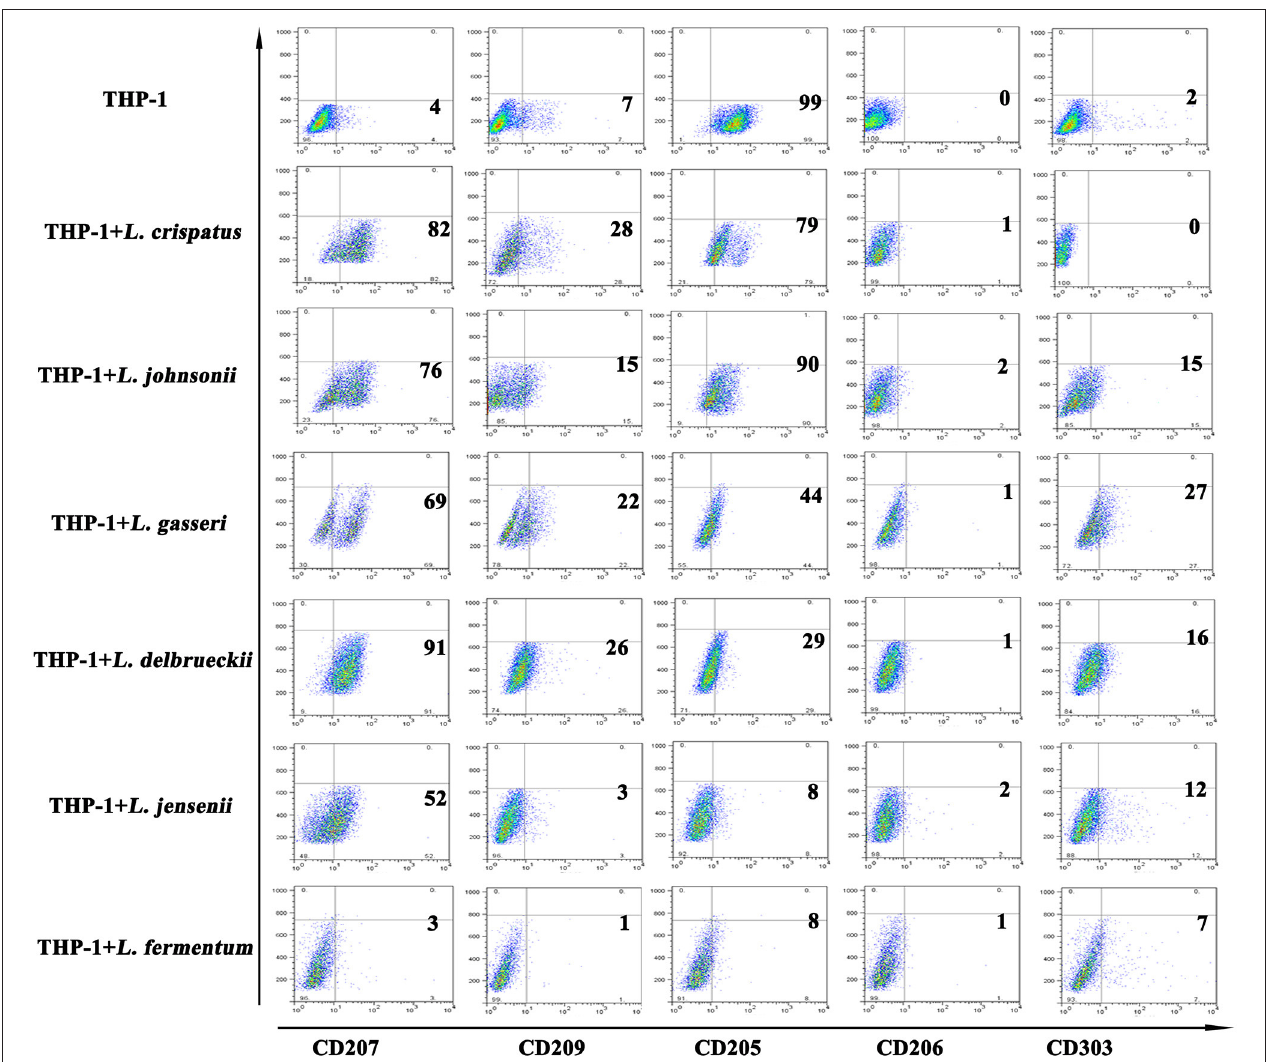
FIGURE 3 | C-type lectin receptors on THP-1 after stimulation with lactobacilli. Flow cytometric results show CD207, CD209, CD205, CD206, and CD303 expression on THP-1 and monocytes stimulated with different species of Lactobacillus ( L. crispatus, L. fermentum, L. jensenii, L. gasseri, L. delbrueckii , and L. johnsonii ) compared to unstimulated THP-1 cells and